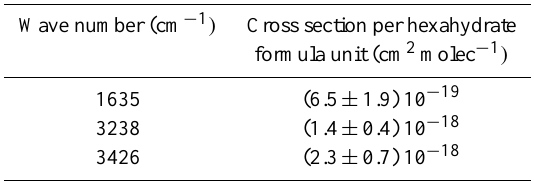
* The measured differential peak absorption cross section for pure vapor-phase deposited ice at 3236cm − 1 is (8.0 ± 0.8) 10 − 19 cm 2 molecule − 1